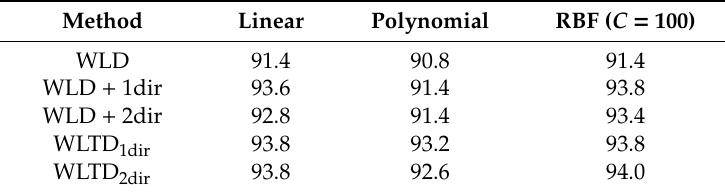
Table 3. Comparison of experimental results between WLD and WTLD of Prewitt